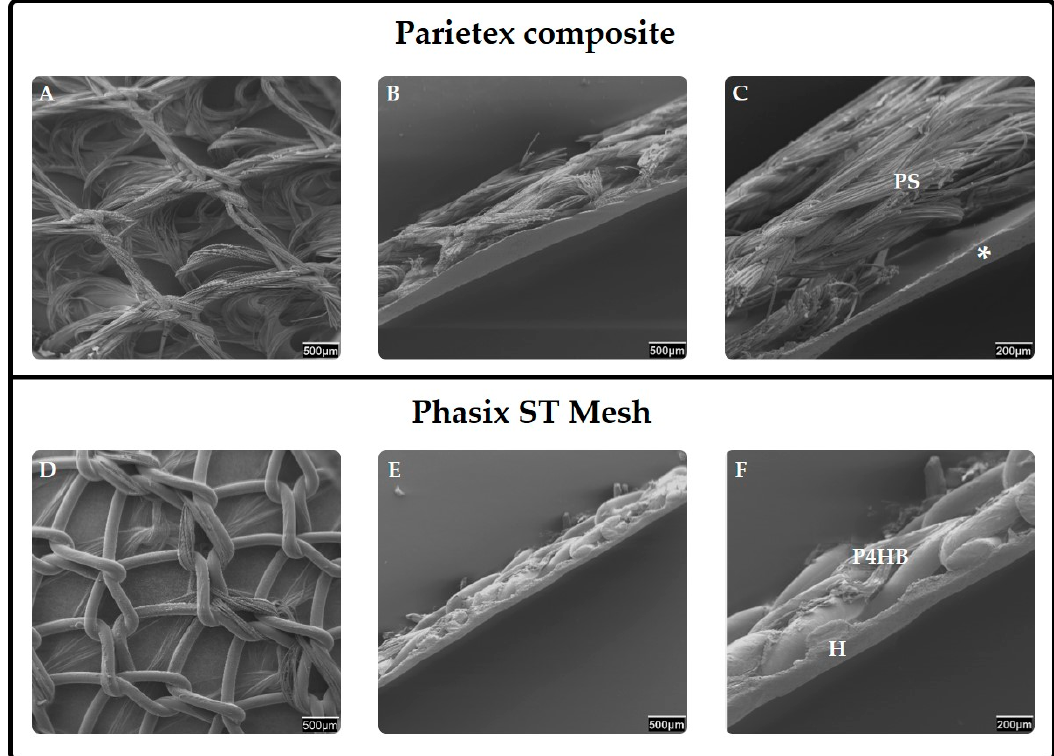
Figure 3. Composites. Scanning electron microscopy images of two different composites containing chemical barriers (Parietex TM composite and Phasix TM ST Mesh) are shown. The reticular mesh facing the abdominal wall is shown in A and D (20x magnification). A lateral view (SEM) of composites is shown in B and E (20x magnification) and C and F (50x magnification). Polyester (PS), Collagen, polyethylene glycol and glycerol layer (*), Poly-4-hydroxybutyrate mesh (P4HB), Hydrogel barrier (H).